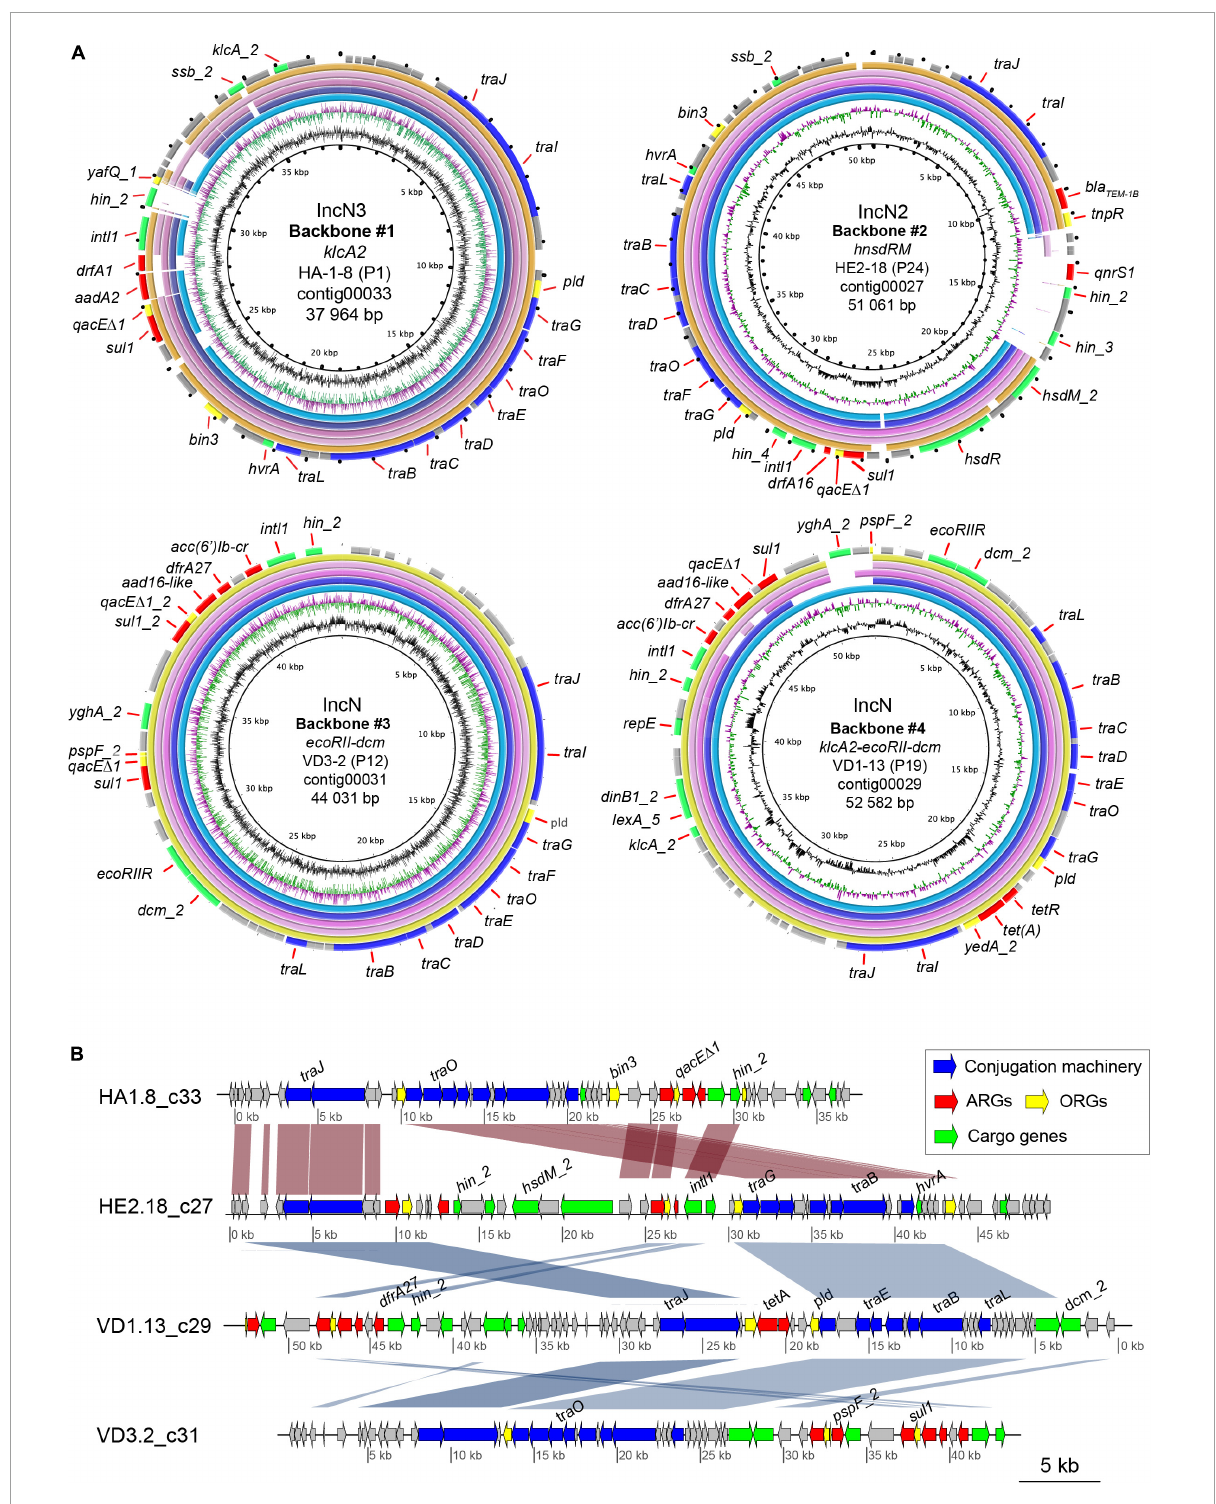
FIGURE7 Comparison between the IncN plasmid-like backbones repeatedly identified in transconjugants from river water using blastn. (A) The top five plasmid genomes with the highest percentage of identity ( > 70%) and query cover were included in the comparison. A plasmid-like backbone was used as the reference sequence (outer ring). The genes present in the reference genome are shown as black dots in the rings that represent the five genomes. The color code for the annotations is listed at the bottom of the figure. The two inner rings depict GC content in black